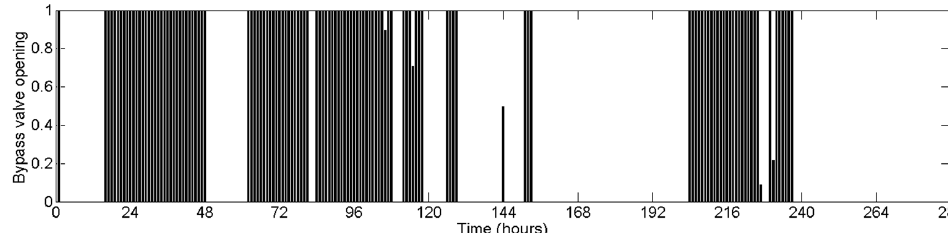
Figure 8. Operational scheduling for the bypass valve of the single NC 150–200 turbine installed at location 3.